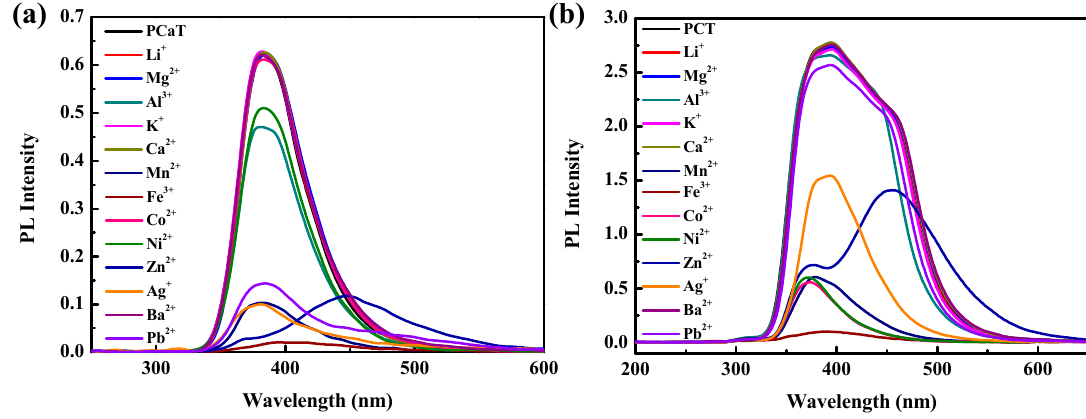
Figure 2. Photoluminescence spectra of ( a ) PCaT and ( b ) PCT in the presence of various metal ions (excitation: 235 nm). Concentration of polymers: 1.0 × 10 − 6 M in THF, concentration of metal ions: 5.0 × 10 − 5 M in water.